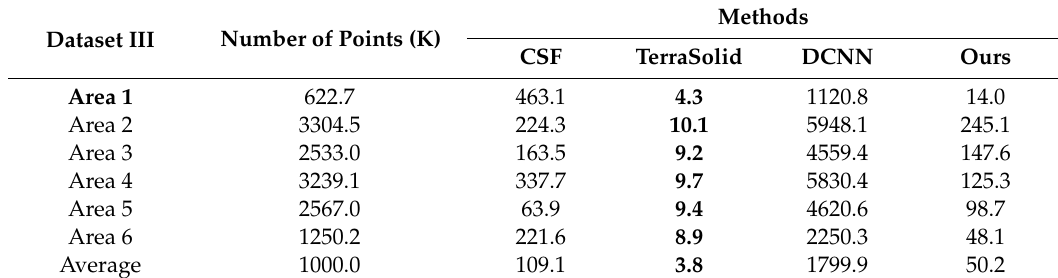
Table 5. Comparison of e ffi ciency with some algorithms